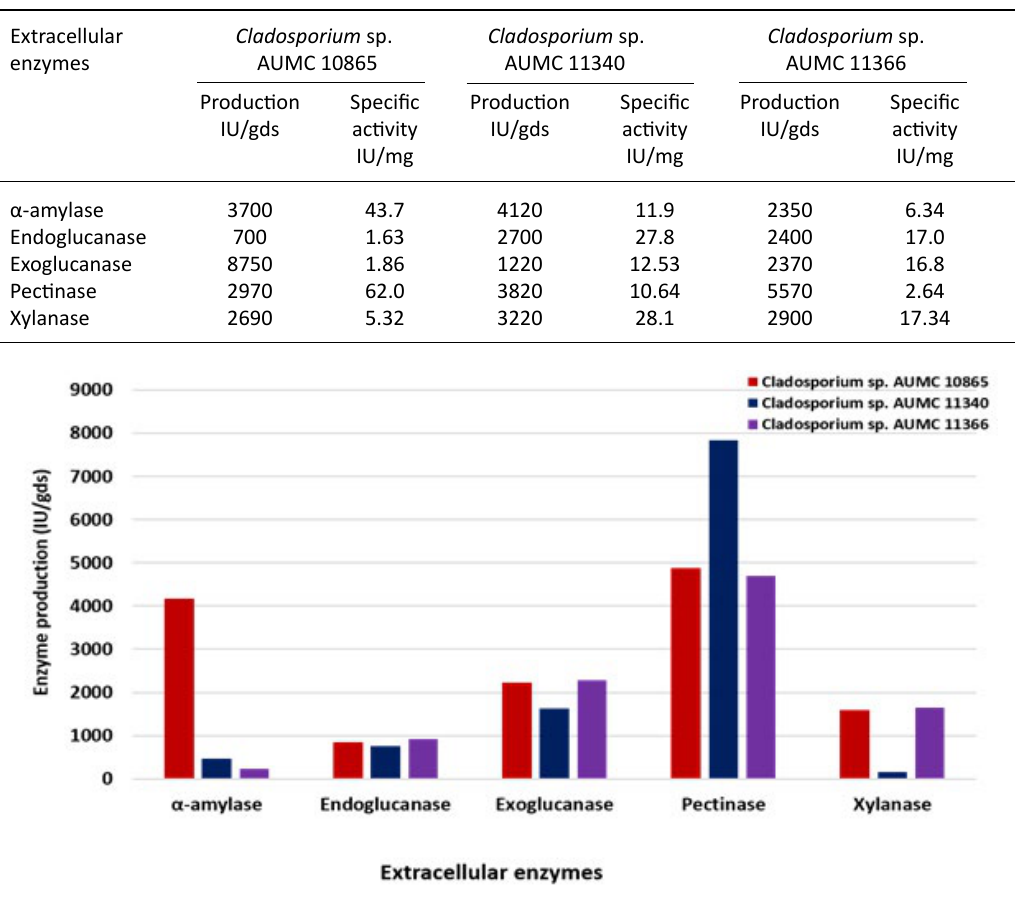
Fig. 2. Enzymes production (IU/gds) by Cladosporium isolates AUMC 10865, AUMC 11340 and AUMC 11366 at 10°C in